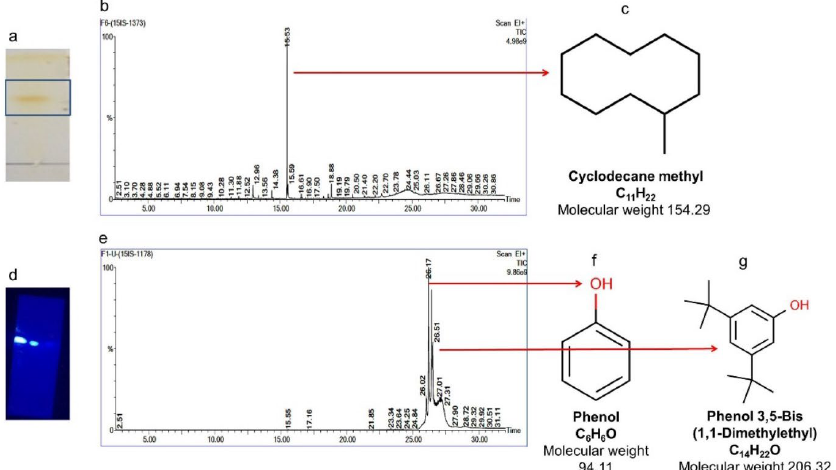
Figure 9. Isolation of compounds 4 and 5. ( a ) TLC showing a single spot of compound eluted at petroleum ether:ethyl acetate (4:6), ( b ) GC-MS chromatogram of cyclodecane methyl, ( c ) molecular weight and structure ( d ) TLC showing a single spot of compound eluted at petroleum ether (100%), ( e ) GC-MS chromatogram of phenol and phenol 3,5-bis(1,1-dimethylethyl). ( f , g ) molecular weight and structure.